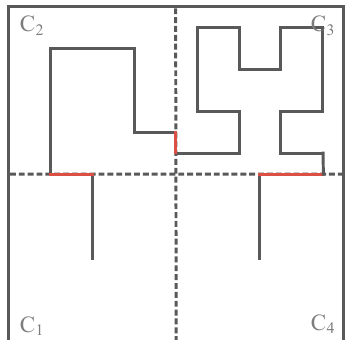
Figure 5. Two adjacent subareas with different curve orders will have a “gap” on their border (the red line).